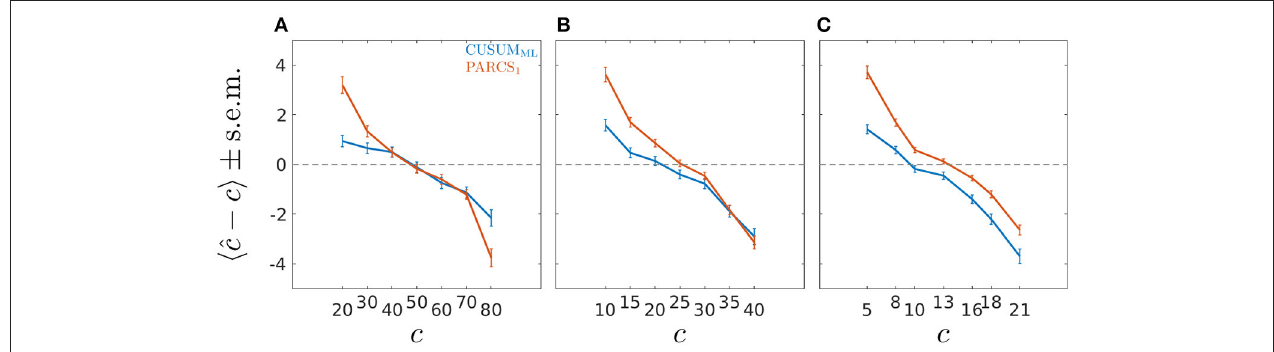
FIGURE 4 | Bias ± s.e.m. in PARCS compared to CUSUM ML with time series of length (A) T = 100, (B) T = 50, and (C) T = 26; noise is temporally independent with σ = 1.0.